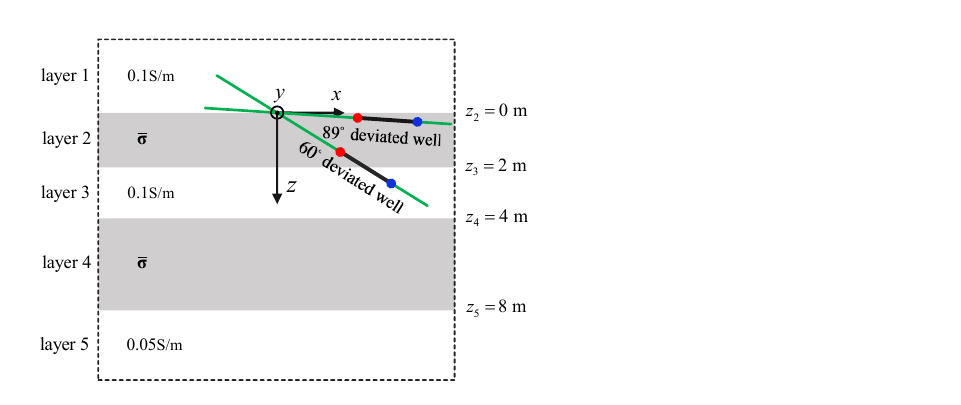
Figure 7. Triaxial logging tool and its orientation. ( a ) Structure of the tool in the tool coordinates t t t x y z . ( b ) Orientation of the tool coordinates t t t x y z with respect to the formation coordinates xyz , where  and  are the tool azimuthal and dip angles, respectively.